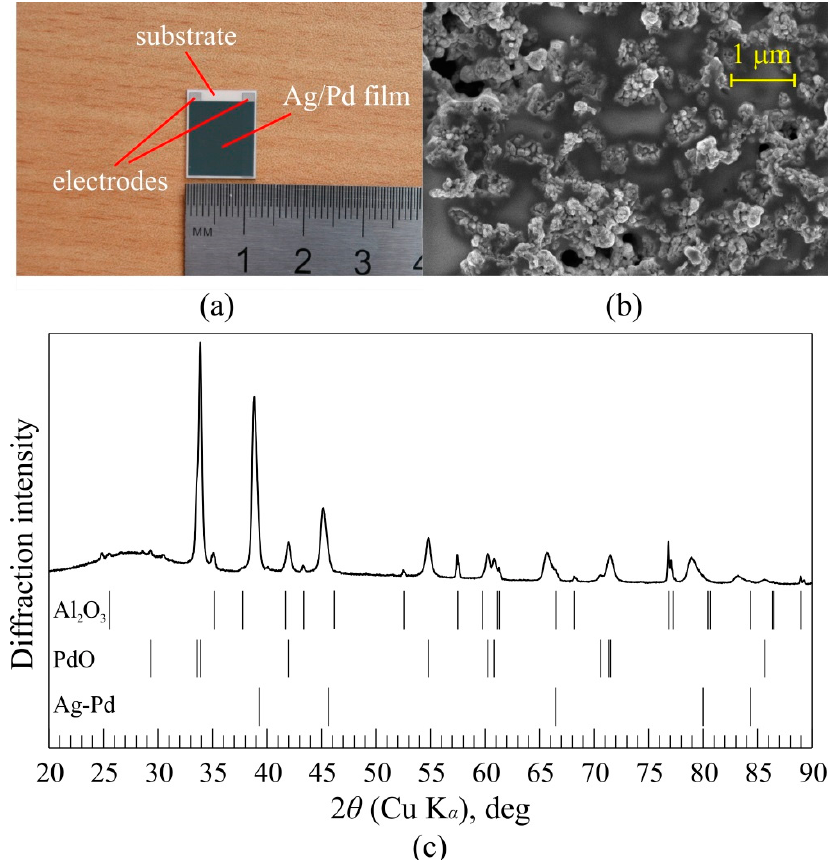
Figure 2. ( a ) The Ag/Pd film with two parallel silver electrodes deposited on the sample’s edges beneath the film; ( b ) scanning electron microscope image of the Ag/Pd film; ( c ) X-ray diffraction patterns of the Ag/Pd film and bar diffraction patterns of detected phases (CuK α ). Al 2 O 3 peaks correspond to the diffraction on the dielectric substrate.